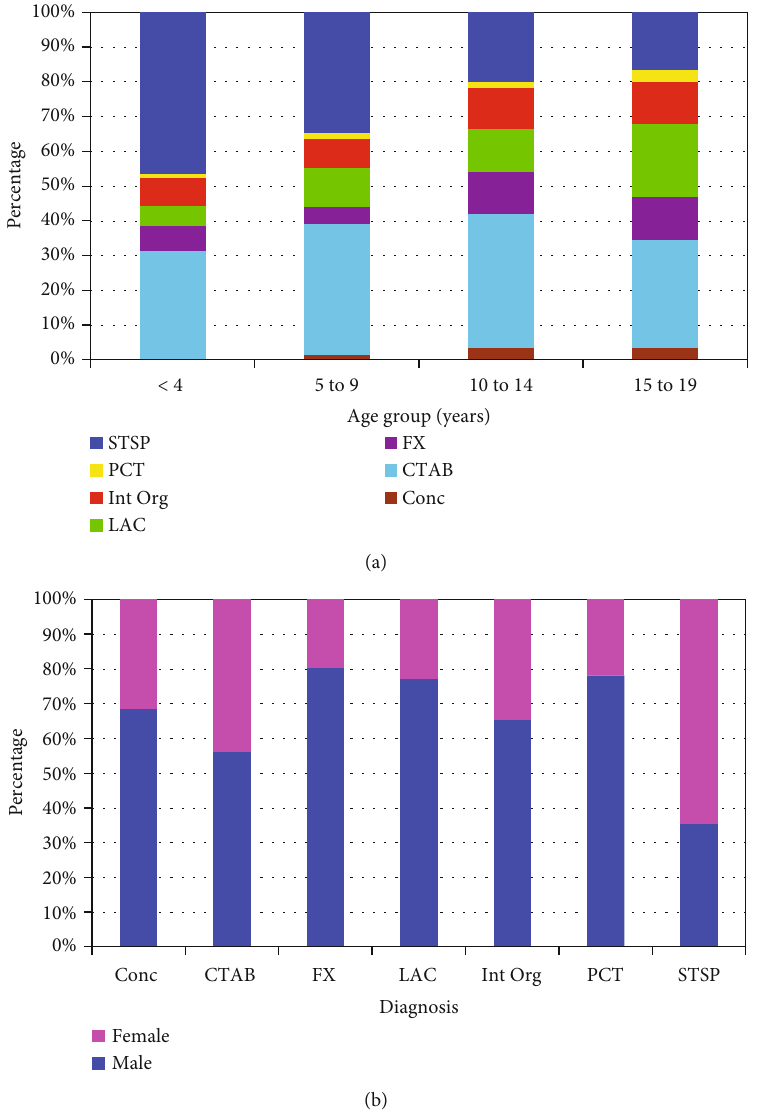
Figure 3: Diagnosis in child and adolescent assault victims. STSP =strain/sprain; PCT=puncture; Int Org=internal organ injury; LAC =laceration; FX =fracture; CTAB =contusion/abrasion; Conc =Concussion. (a)By age group ( p < 10 − 4 ). (b) By gender ( p < 10 − 4